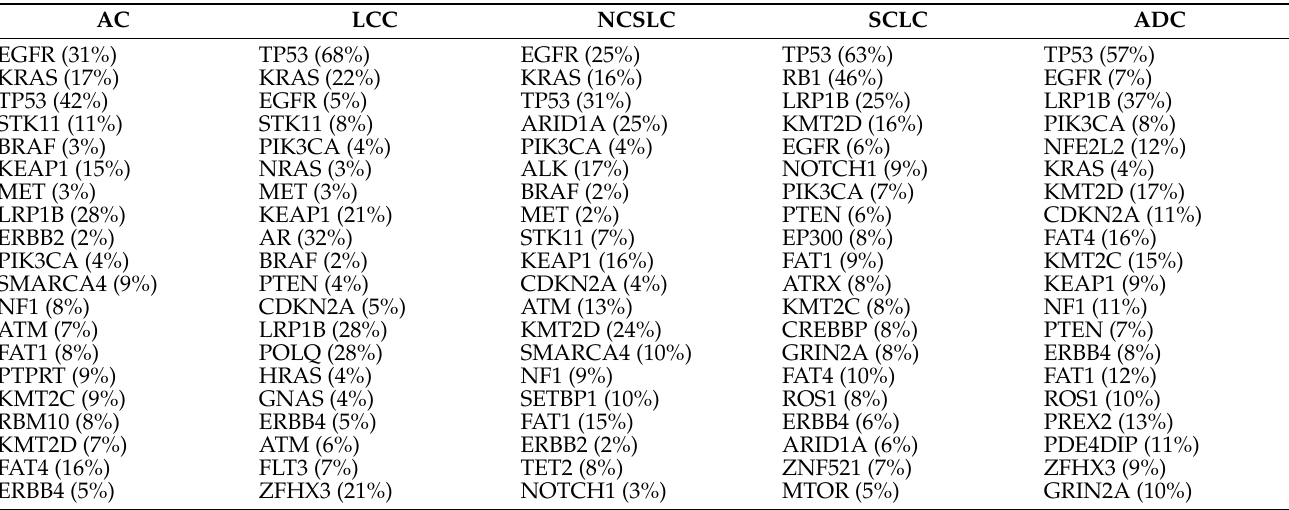
Table 1. List of the 20 most mutated genes by lung cancer subtype (adapted from